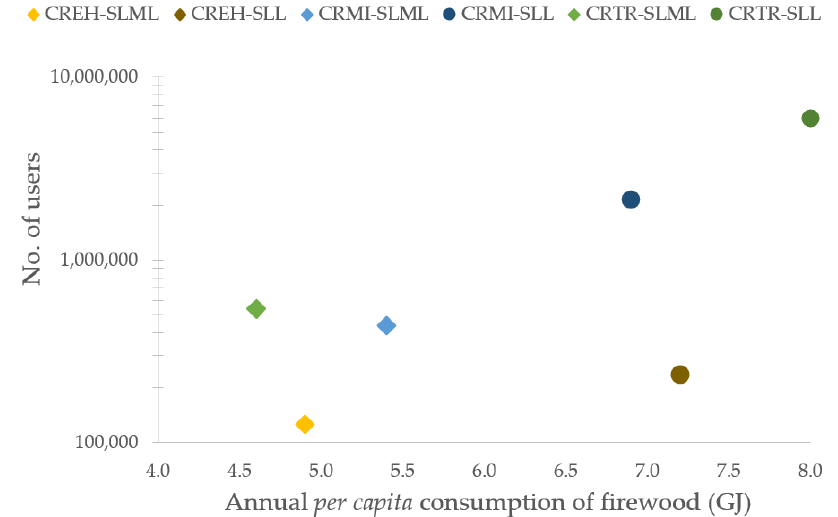
Figure 5. Annual per capita consumption of firewood and number of EFU in socioeconomic levels (SL), by climate region (CR). EH, extreme heat; MI, mild; TR, tropical; ML, moderately low; L, low. Source: Own elaboration.